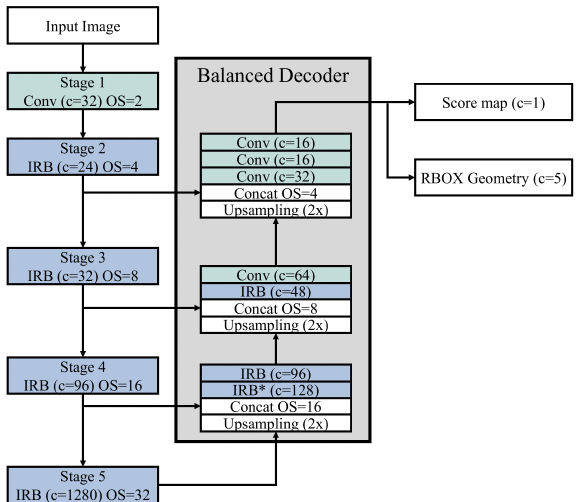
Figure 2. Structure of the proposed CAST. The five stages on the left represent MobileNetV2, while the center box is the balanced decoder. With the inverted residual block (IRB), and IRB* is a special case without any expansion. Convolutions of kernel size 3x3 are denoted by Conv . Here c indicates the number of channels, and OS represents the output stride.